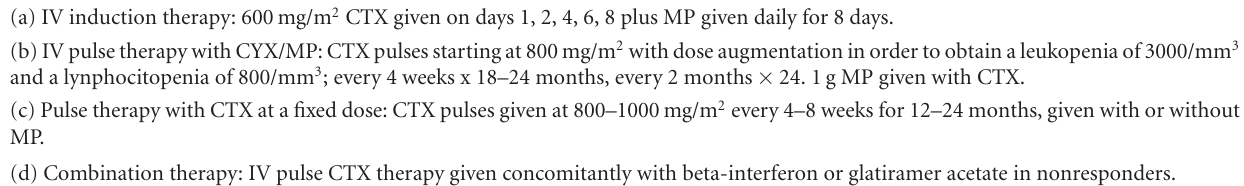
Table 2: Treatment